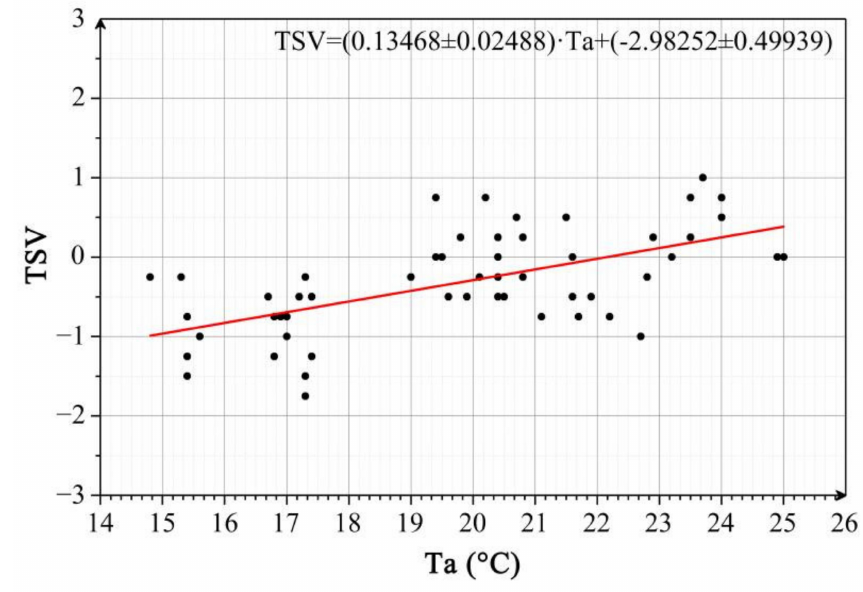
Figure 12. The quantitative relationship between TSV and Ta.